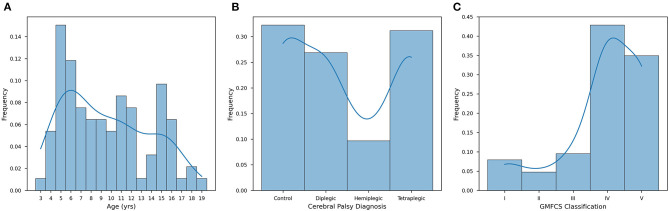
Distribution patterns of the CP study population. (A) Individuals from the cohort aged from 3 to 19, with a mean age of 9.57 ± 4.20 years (n = 93). (B) The study population was composed of healthy individuals (controls, 32.26%), tetraplegics (32.26%), diplegics (26.88%), and hemiplegics (9.68%). (C) Distribution is measured along the GMFCS scale from I-V for only G1 and G2. Stages I-III are considered ambulatory, while stages IV and V require significant assistance (typically a wheelchair or mobility scooter). Stages I, II, and III are less represented (7.94%, 4.76%, and 9.52%, respectively), while stages IV (42.86%) and V (34.92%) make up the vast majority of G1 and G2 (n = 93). For each of these histograms, an LM regression is overlaid to make visual trend observation more convenient.